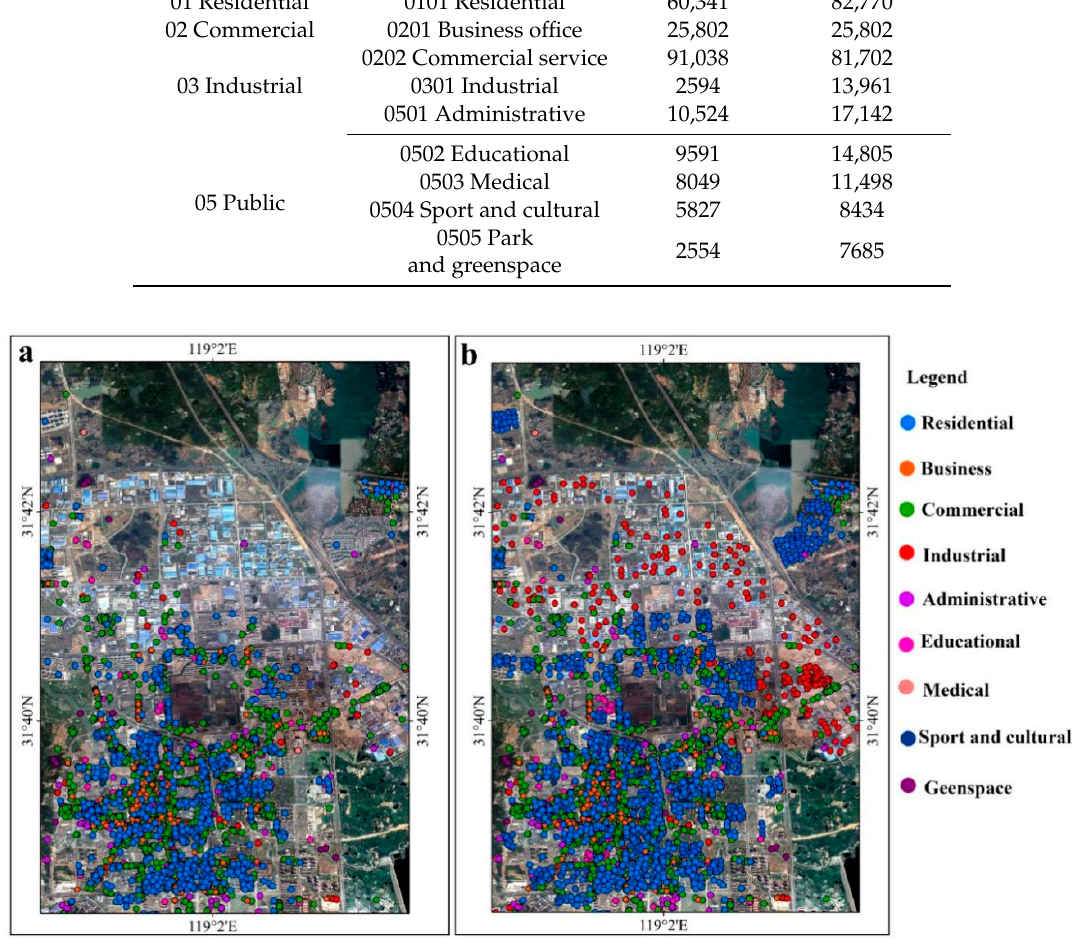
Figure 7. A spatial distribution of ( a ) the original POI points and ( b ) the regenerated POI points.